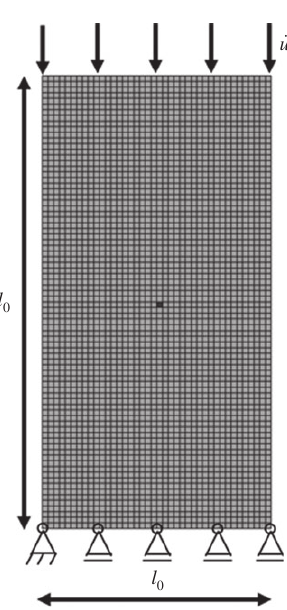
× 2 l with dimension l . The mesh consists of 1 0 0